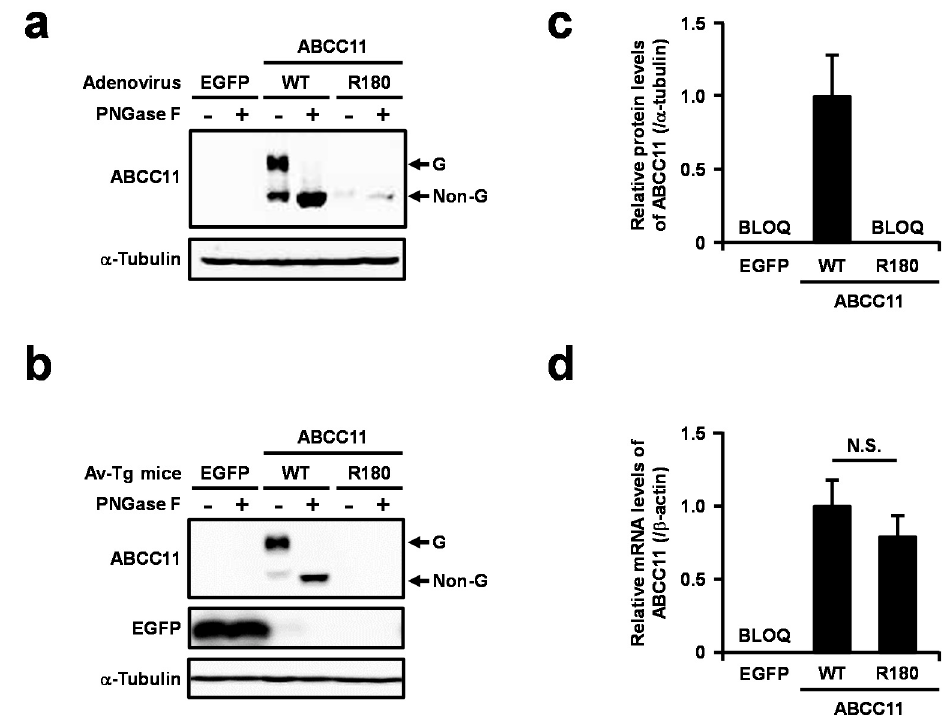
Figure 1. Effect of single nucleotide polymorphism (SNP) 538G>A (G180R) on the expression of the ATP-binding cassette C11 (ABCC11) protein in transiently transgenic mice. ( a ) Immunoblotting detection of the ABCC11 protein expressed in Hepa1-6 cells. The function of the ABCC11 wild-type (WT) expressed by the adenovirus vector was confirmed using an in vitro vesicle transport experiment (Figure S2). The immuno-reactive band corresponding to the glycosylated form (G) of the ABCC11 protein disappeared after peptide N -glycosidase F (PNGase F) treatment. Non-G: non-glycosylated form; α -Tubulin: a loading control; ( b ) Maturation status and expression of the ABCC11 protein in the liver of adenovirus-infected transiently transgenic (Av-Tg) mice; ( c ) Densitometric analysis of ABCC11 protein levels in each group of Av-Tg mice. n = 4; ( d ) ABCC11 mRNA levels in each group of Av-Tg mice. The mRNA levels were normalized to the WT (control) level. n = 5. β -Actin: a housekeeping gene for internal control. Data are expressed as mean ± S.E.M. N.S., not significantly different between groups. BLOQ, below limit of quantification.